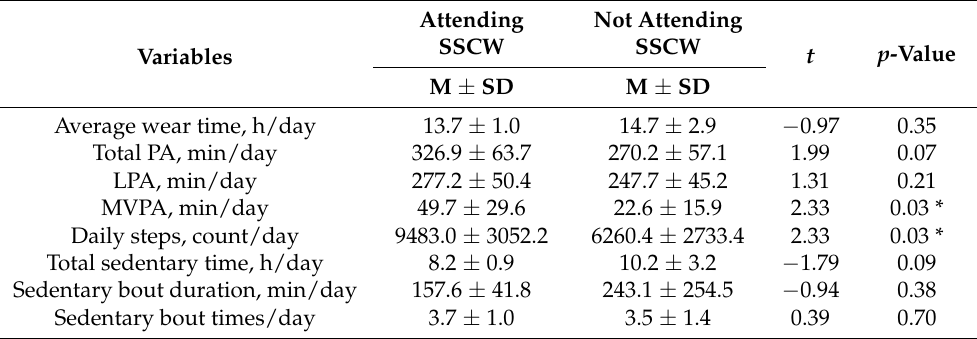
Table 2. Total Amounts and Patterns of Physical Activity and Sedentary Behavior Patterns during 7-day period in Prader-Willi syndrome adults with and without attending